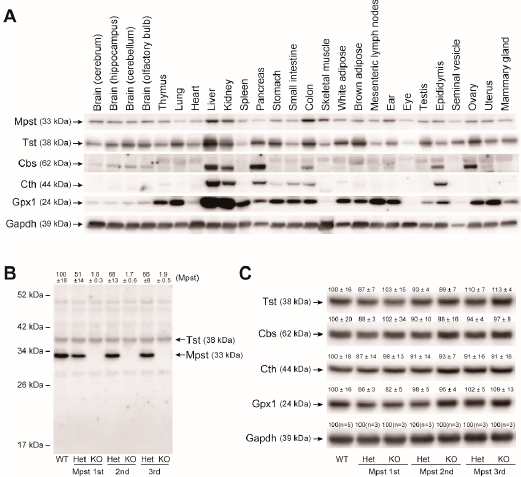
Figure 2. Tissue expression of mercaptopyruvate sulfurtransferase (Mpst) and related proteins in adult wild-type and Mpst mutant mice. All samples were taken from males except for the ovary, uterus, and mammary gland. ( A ) Western blot analysis of Mpst, Tst (thiosulfate sulfurtransferase), Cbs (cystathionine β -synthase), Cth (cystathionine γ -lyase), Gpx1 (glutathione peroxidase 1), and Gapdh (glyceraldehyde-3-phosphate dehydrogenase; as a loading control) in various mouse tissues. ( B ) Western blot analysis of the liver Mpst (and Tst) in wild-type (WT), heterozygous (Het), and homozygous (KO) Mpst mutant mice (1st–3rd lines) using the anti-mouse Mpst rabbit polyclonal antibody produced in this study. Relative amounts of Mpst protein was expressed as % of the WT samples (mean ± SD; n = 3 each). ( C ) Hepatic expression of Tst, Cbs, Cth, Gpx1, and Gapdh using specific antibodies in WT, Het, and KO mice (1st–3rd lines). Relative expression of each protein was expressed as % of the WT samples (mean ± SD; n = 3